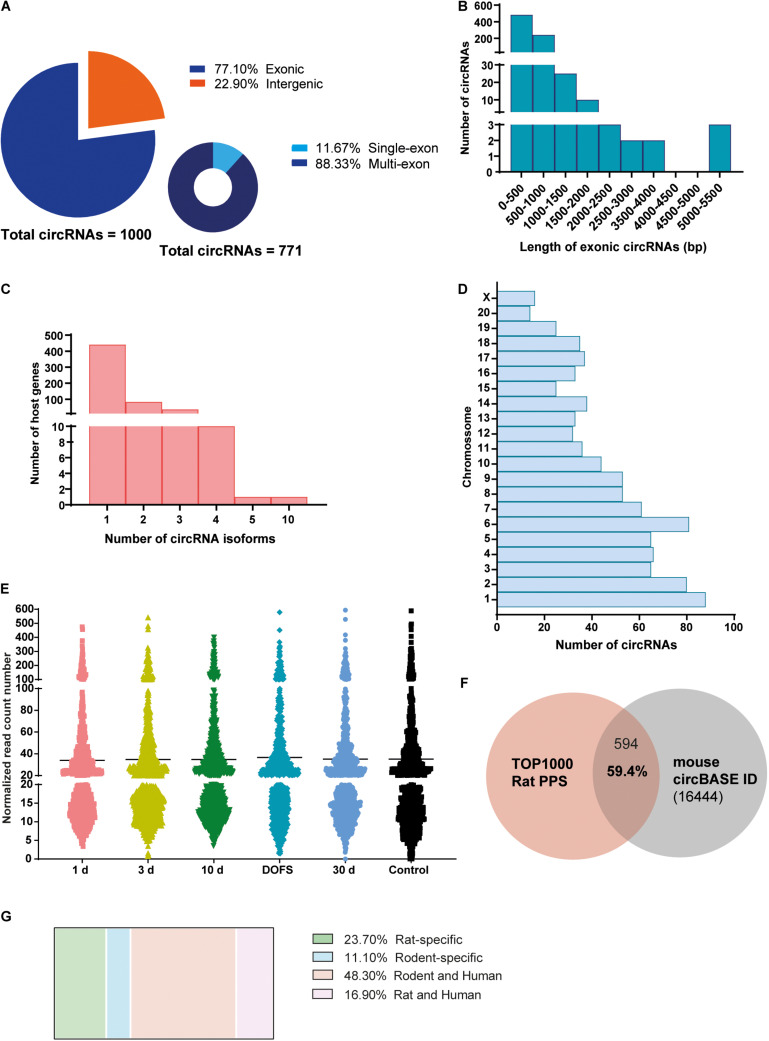
Characterization of circRNA profiling in the PPS rat model. (A) Distribution of detected circRNAs in the rat perforant pathway stimulation (PPS) model in different circRNA categories (exonic, intergenic, single-exon and multi-exon). (B) Size distribution of different exonic circRNAs, n = 771. (C) Distribution of the number of circRNA isoforms per host gene. (D) Distribution of circRNAs across the different rat chromosomes. (E) Expression levels of detected circRNAs across the different experimental groups (1 day, 3 days, and 10 days after PPS, day of first spontaneous seizure (DOFS), 30 days after DOFS and control). Expression levels are shown as the normalized number of RNA-seq reads and each dot represents a specific circRNA. Values are plotted as a scatter to illustrate the spread of data values around the mean (black line). (F) Overlap between the 1000 most highly expressed circRNAs detected by RNA-seq and circBase annotated circRNAs (total of 16444 unique Mus musculus circRNAs). 59.4% of the circRNAs are conserved in Mus musculus and can be found in circBase. (G) Species conservation of all detected circRNAs, expressed as% of the total number of circRNAs found.